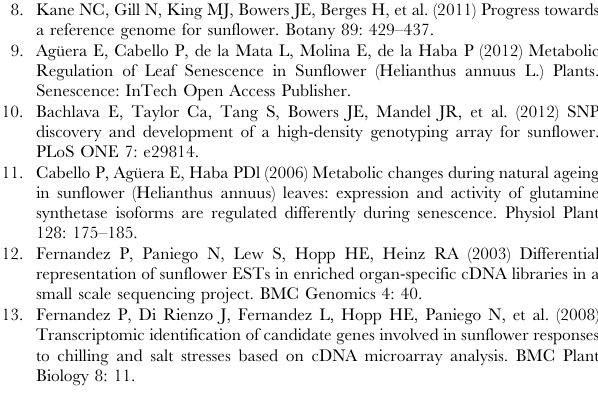
Table S2 BlastX results and Transcription Factor domain detected using Conserved Domain